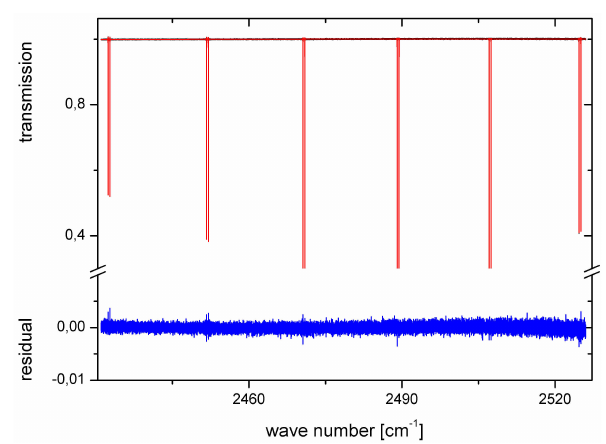
Fig. 1. Transmission spectrum recorded with the HBr NDACC cell #44 (black) and superimposed on it the LINEFIT calculation (red). The fit residual is shown in blue. The measurement has been recorded with the TCCON FTIR spectrometer in Karlsruhe on 10 November